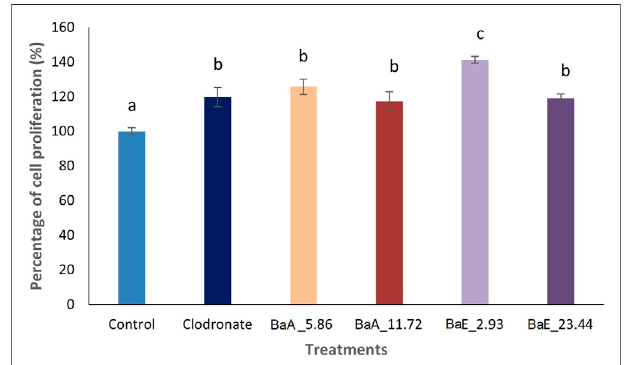
FIGURE 3 | Cell proliferation activity of MC3T3-E1 (osteoblast) cells after treatment with different concentrations of B. acmella aqueous ( Ba A) and ethanol( Ba E)extractsatDay1.BaE_2.93( Ba Eat2.93 µg/ml),BaE_23.44( Ba E at 23.44 µg/ml), BaA_5.86 ( Ba A at 5.86 µg/ml) and BaA_11.72 ( Ba A at 11.72 µg/ml). Results (optical densities) were calculated as mean ± SEM. Differentalphabetsindicated signi fi cancedifferences( p ≤ 0.05)( n (cid:2) 6)between treatments.